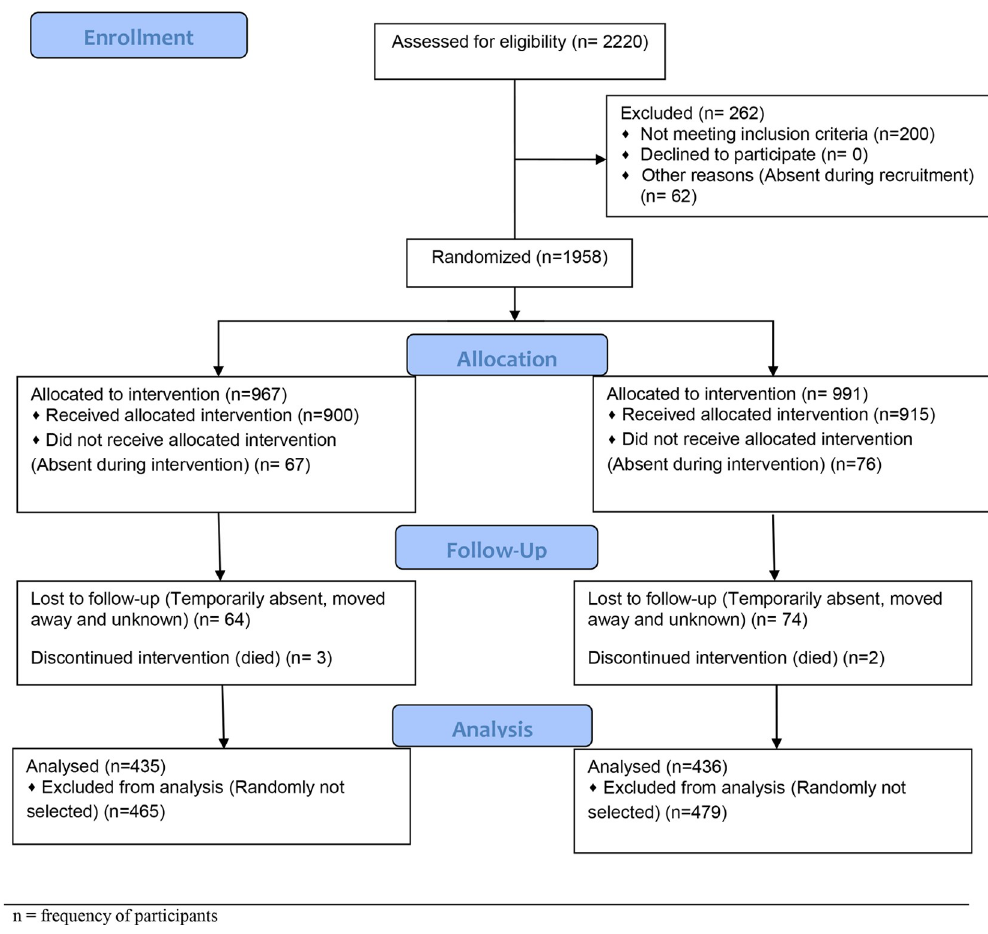
Fig 1. Flow diagram for participants’ selection and